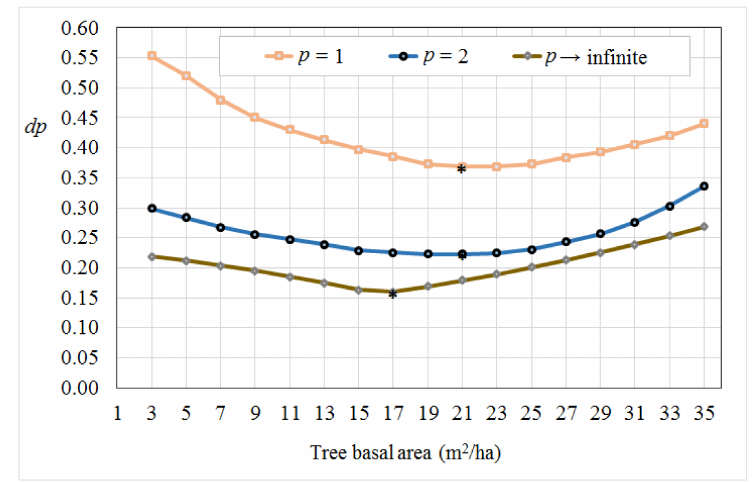
Figure 5. Results from the compromise programming model for the four ecosystem services evaluated. The asterisks represent the point with minimum distance between the efficient frontier and the ideal